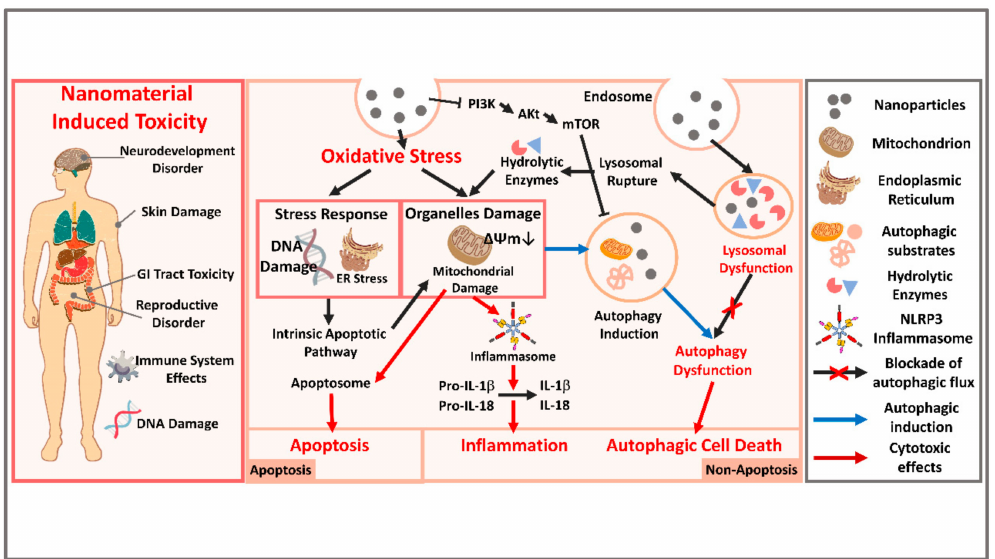
Figure 1. An overview of the mechanism of nanomaterial-induced autophagy-related toxicity and subsequent systematic potential toxic e ff ects. The overall toxicity caused by nanomaterials includes neurodevelopmental disorders, skin damage, gastrointestinal tract toxicity, reproductive disorders, immune system e ff ects, DNA damage, and so on. One of the major forms of toxicity caused by nanomaterials is the oxidative stress induced by ROS and resulting in ER stress and mitochondria and DNA damage. The stress response and organelle damage can eventually induce apoptotic cell death. ROS production results in mitochondrial damage that activates the NLRP3 inflammasome and cellular inflammation. Another major implication for nanomaterial-induced toxicity is autophagy